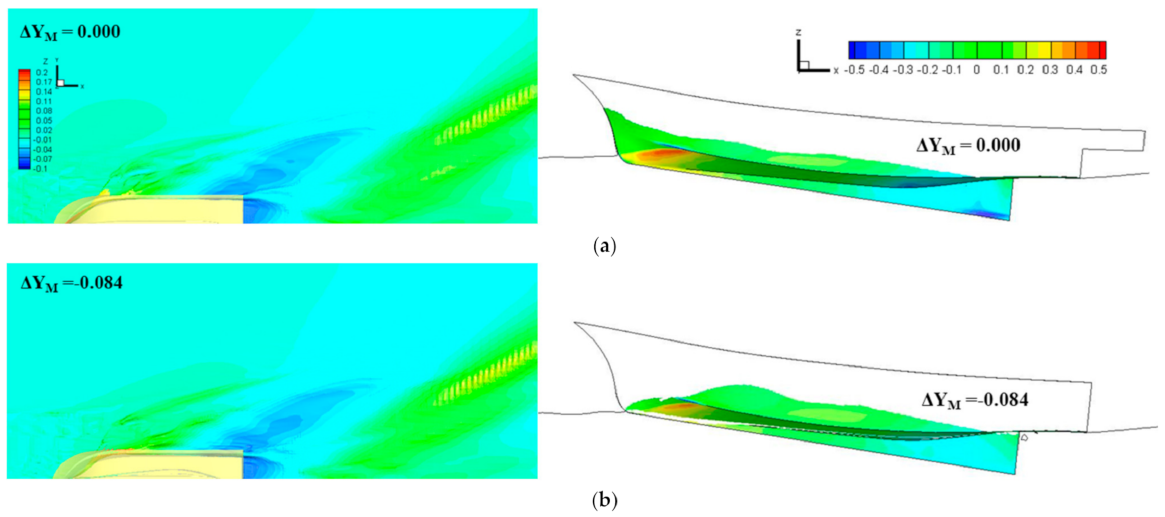
Figure 8. Comparison of wave pattern and pressure distribution of the initial and optimum hull form at design speed. ( a ) Initial hull ( ∆ Y M = 0.000); ( b ) optimal hull ( ∆ Y M = − 0.084 ).